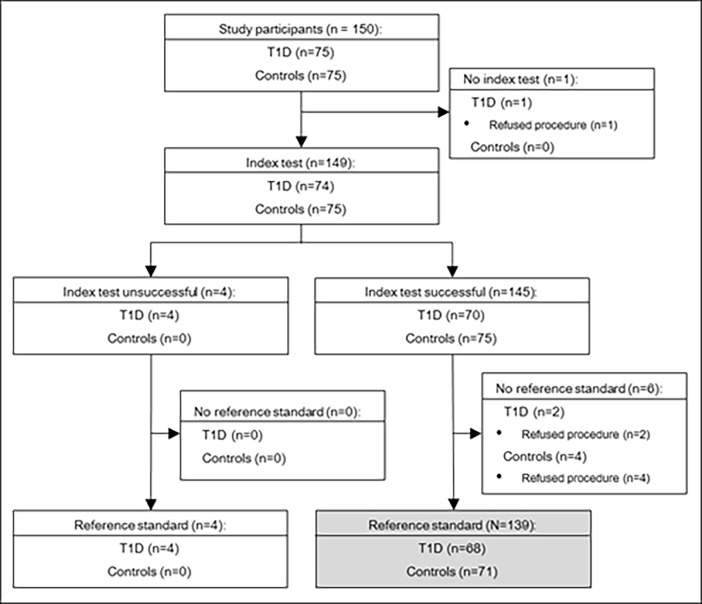
Flow of study participants.Of the 150 study participants in the Canadian Study of Longevity in Type 1 Diabetes, 1 refused the POCD procedure (index test) and 6 refused the NCS procedure (reference standard). Four study participants were excluded due to device errors using the POCD, resulting in 139 participants for analysis.